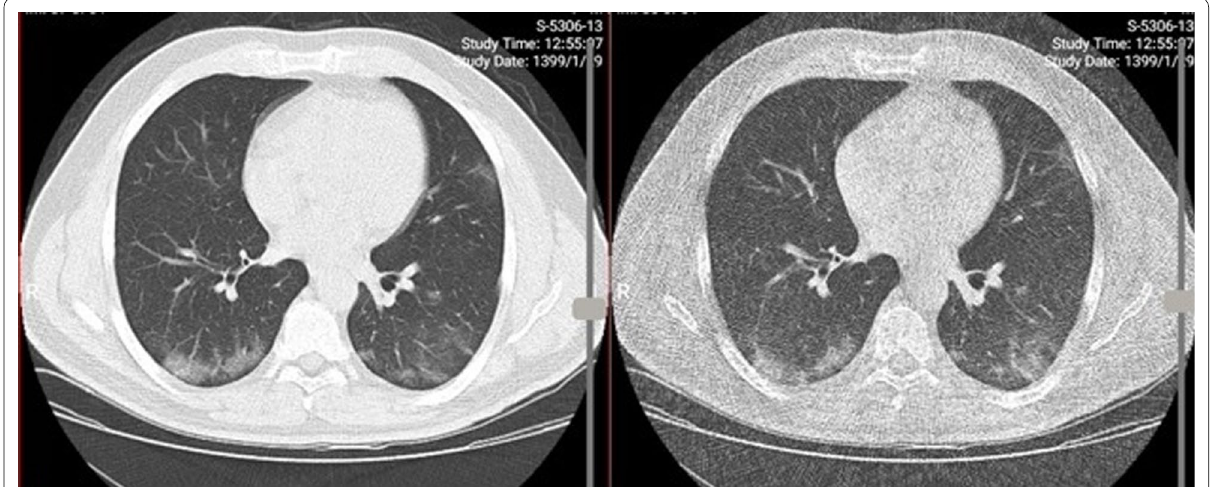
NPV negative predictive value, PPV positive predictive value